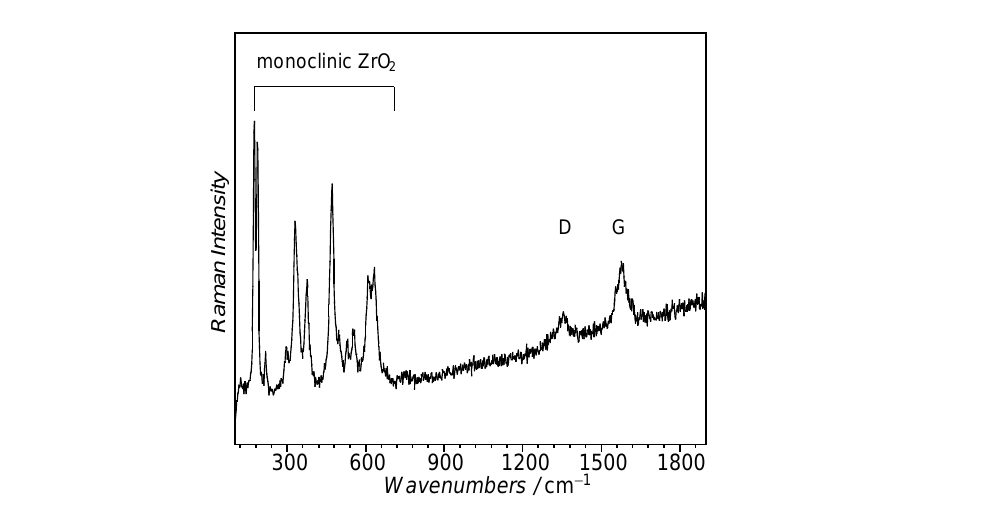
Figure 9. Raman spectrum of the 5.1Ni/Z m ( red ) used catalyst. D and G identify disordered-graphite and graphite bands, respectively.